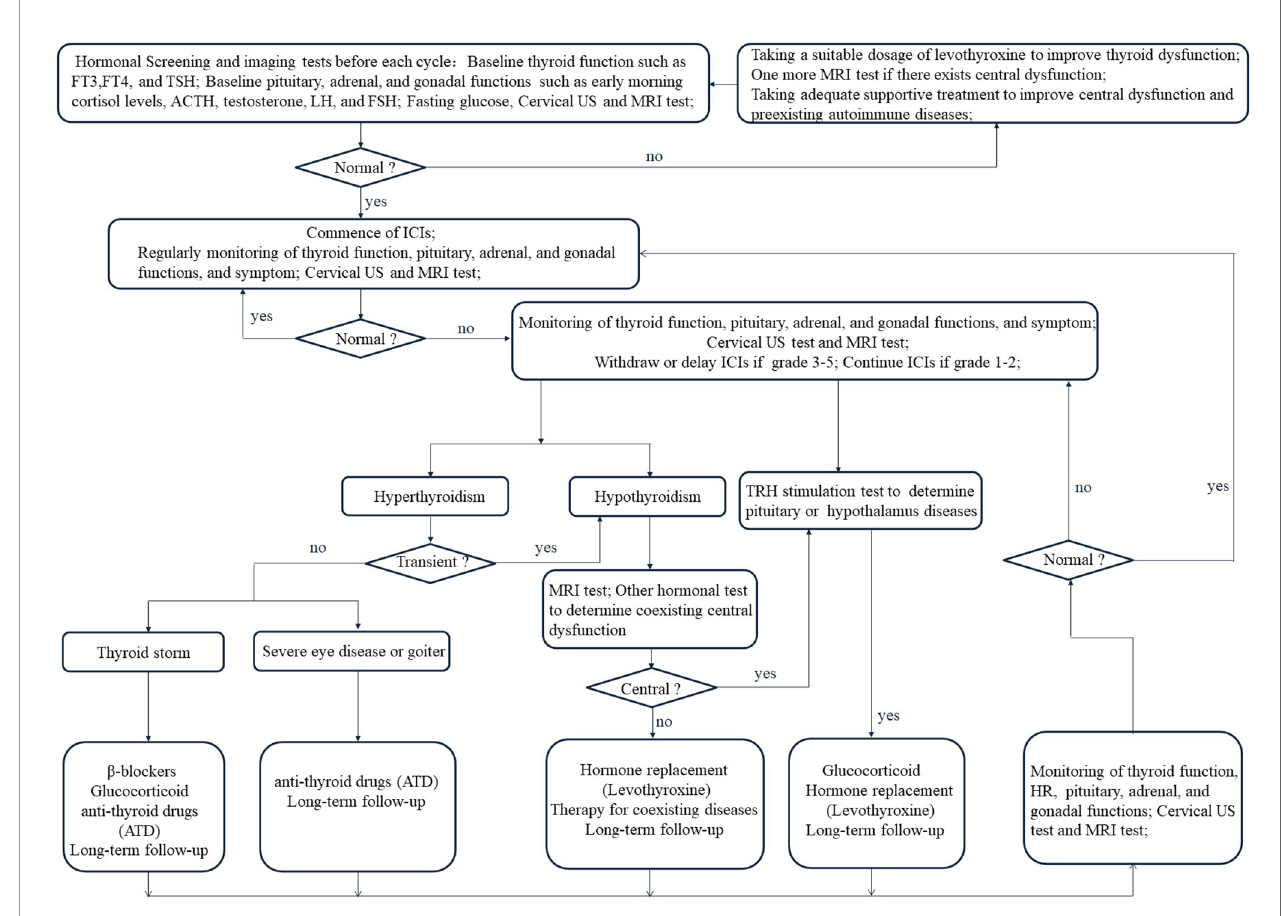
FIGURE 4 | Management fl ow chart for Immune checkpoint inhibitors-related thyroid dysfunction. FT3, free triiodothyronine; FT4, free thyroxine; TSH, thyroid- stimulating hormone; ACTH, adrenocorticotropic hormone; LH, luteinizing hormone; FSH, follicle-stimulating